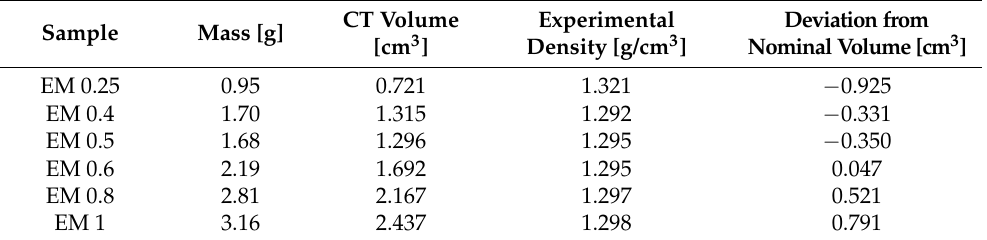
Figure 5. Photos and dimensional deviations of the wall thickness for the hollow test cubes 3D printed with different EM values. Table 5. Characterization of weight, printing time and energy consumption for hollow cubes fabri- cated with different values of the Extrusion Multiplier